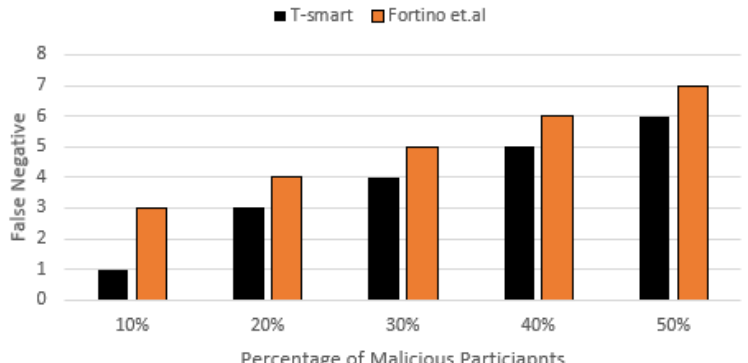
Figure 4. FP with 10–50% dishonest participants.